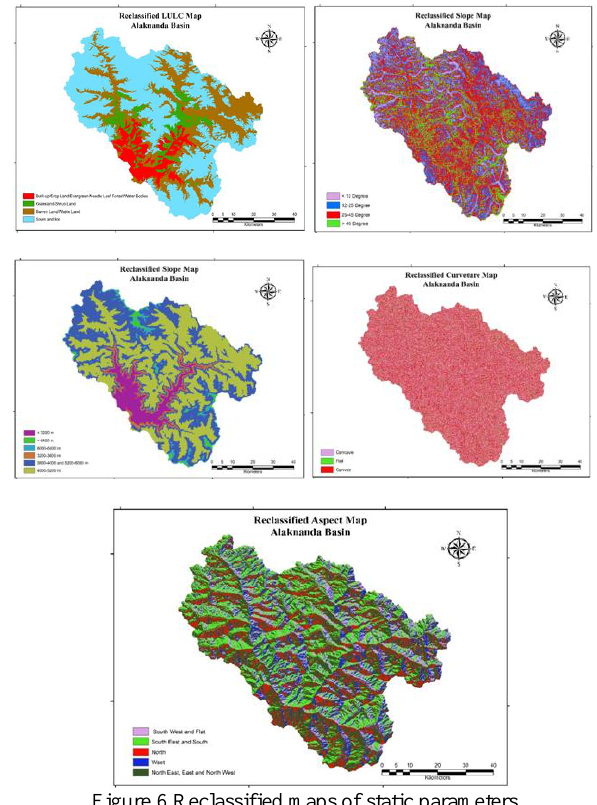
Figure 6 Reclassified maps of static parameters 3.3 Derivation of weights for different